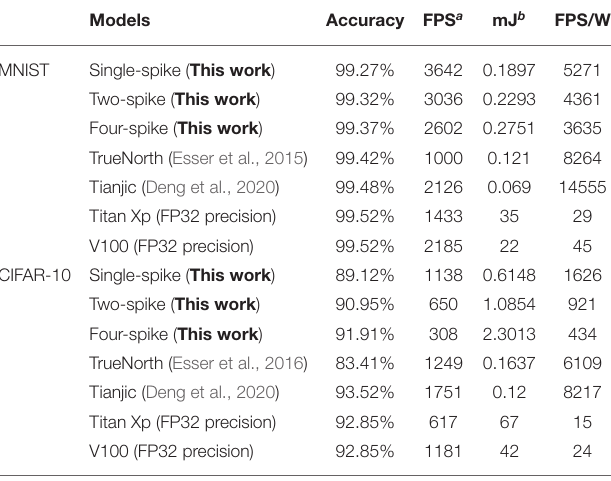
TABLE 11 | Summary of main